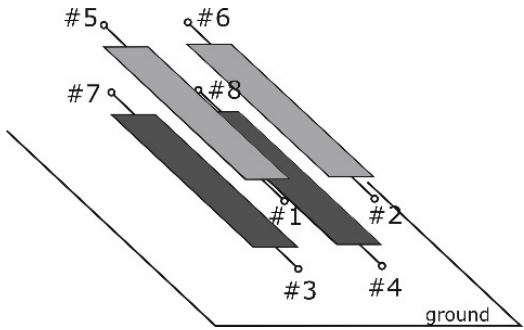
Figure 1. A conceptual view of a four ‐ strip coupled ‐ line system which can operate as differentially ‐ fed coupled ‐ line directional coupler, having differential excitation provided between the appropriate balanced ports: #1 and #2, #3 and #4, #5 and #6, #7 and #8. balanced ports: #1 and #2, #3 and #4, #5 and #6, #7 and #8.